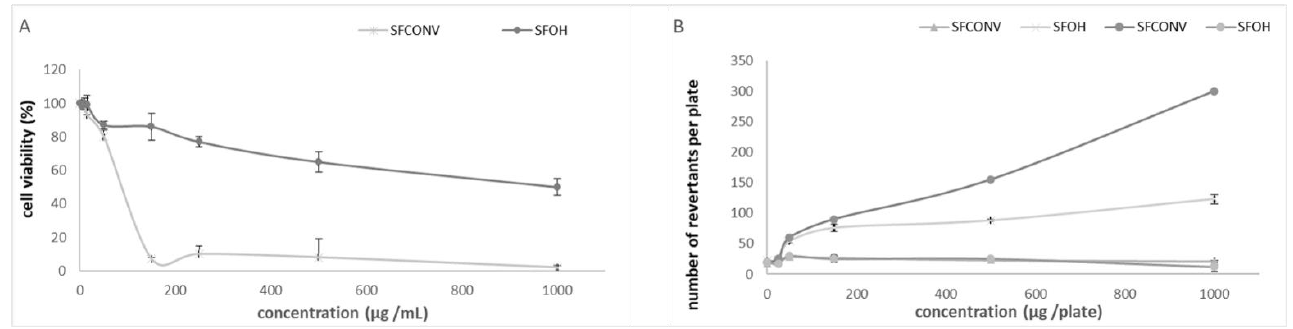
Figure 4. Cytotoxicity ( A ) and mutagenicity ( B ) of SFOH and SFCONV samples. In figure ( B ), rep- resent without metabolization and with metabolization. Results are the means of three determina- tions ± standard deviation.